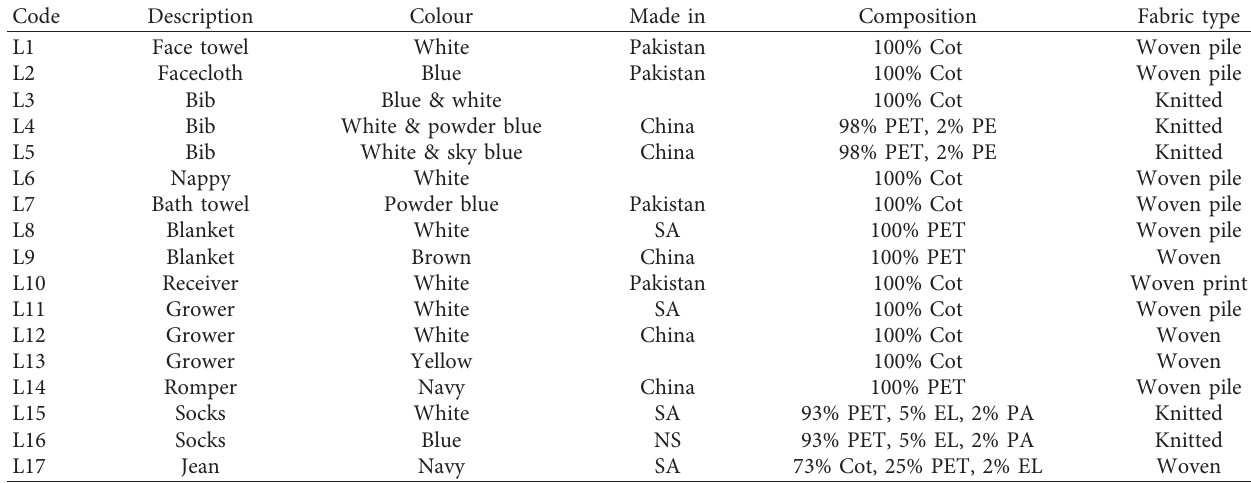
Table 2: Sample code, description, composition and apparel type from a low end market